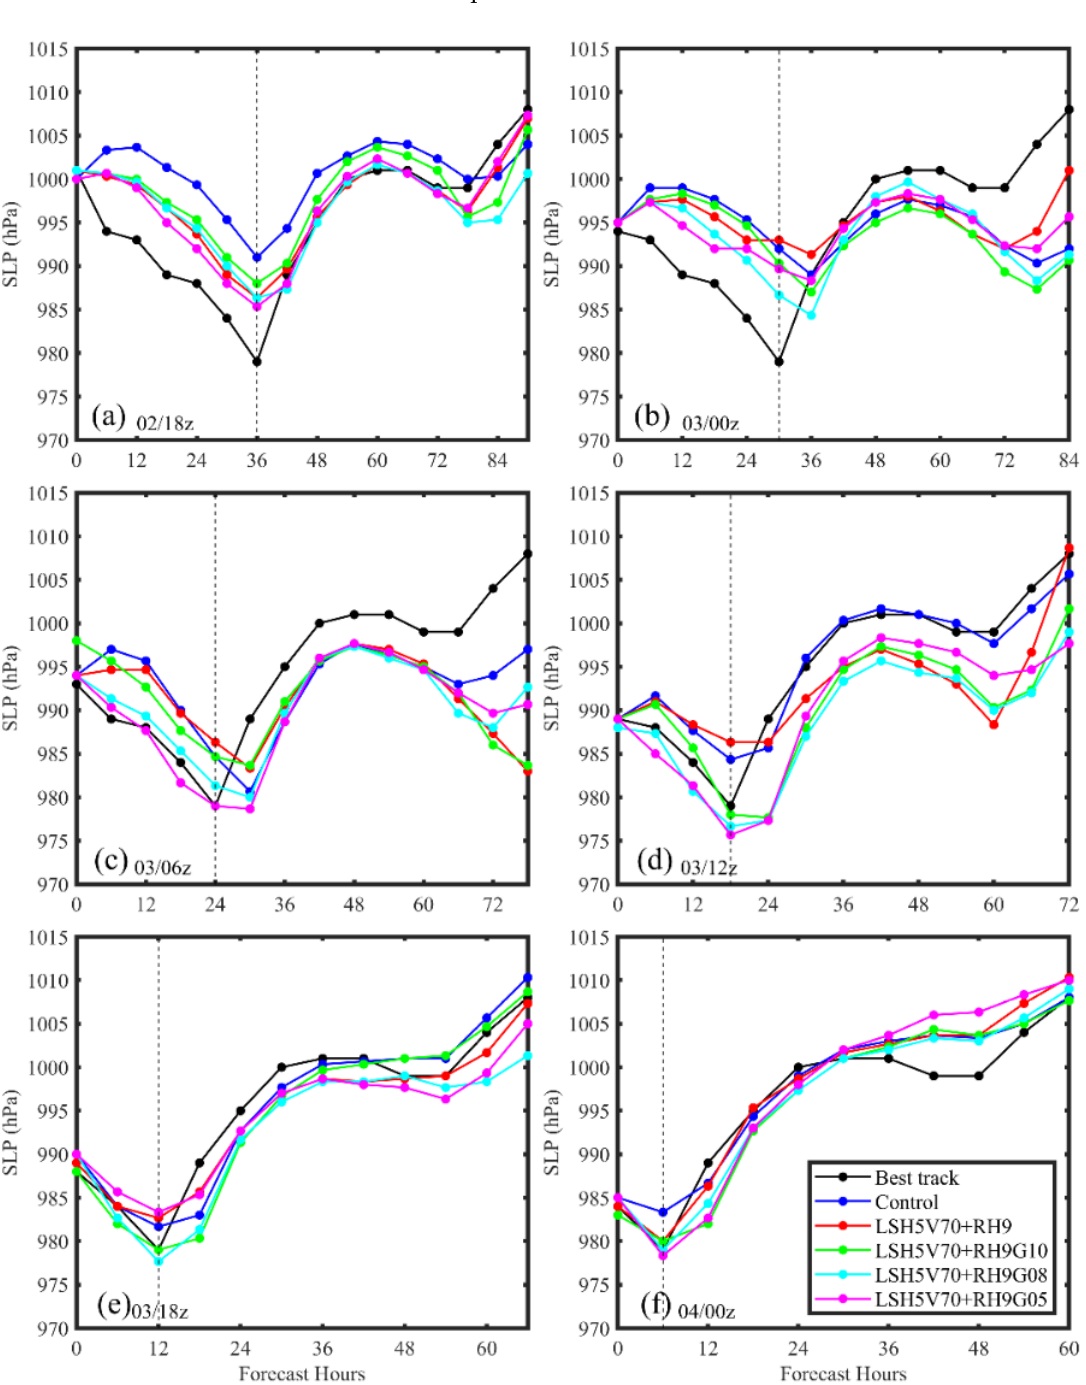
Figure 15. Comparison of the forecast SLP for Hurricane Earl from Control, LSH5V70 + RH9, LSH5V70 + RH9G10, LSH5V70 + RH9G08, and LSH5V70 + RH9G05 at ( a ) 18 UTC 2, ( b ) 00 UTC 3, ( c ) 06 UTC 3, ( d ) 12 UTC 3, ( e ) 18 UTC 3, and ( f ) 00 UTC 4 August 2016.